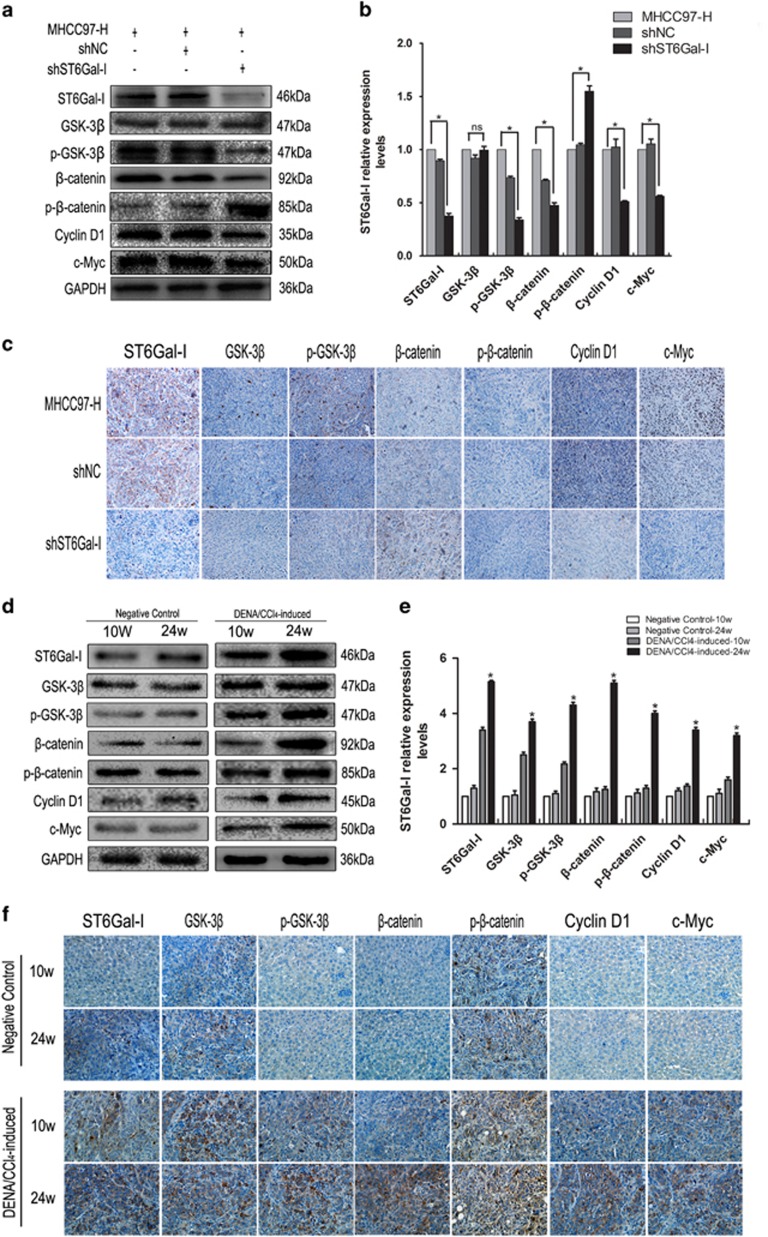
Altered expression of ST6Gal-I affects liver tumorigenesis via the Wnt/β-catenin signaling pathway in mice. (a, c) Western blotting and IHC were used to detect the expression levels of GSK-3β, p-GSK-3β, β-catenin, p-β-catenin, Cyclin D1 and c-Myc proteins in tumor tissues. (d, f) Western blotting and IHC analyses revealed differential expression of these proteins in liver tumorigenesis. (b, e) Relative protein intensities as determined by Image Lab. *P<0.05.